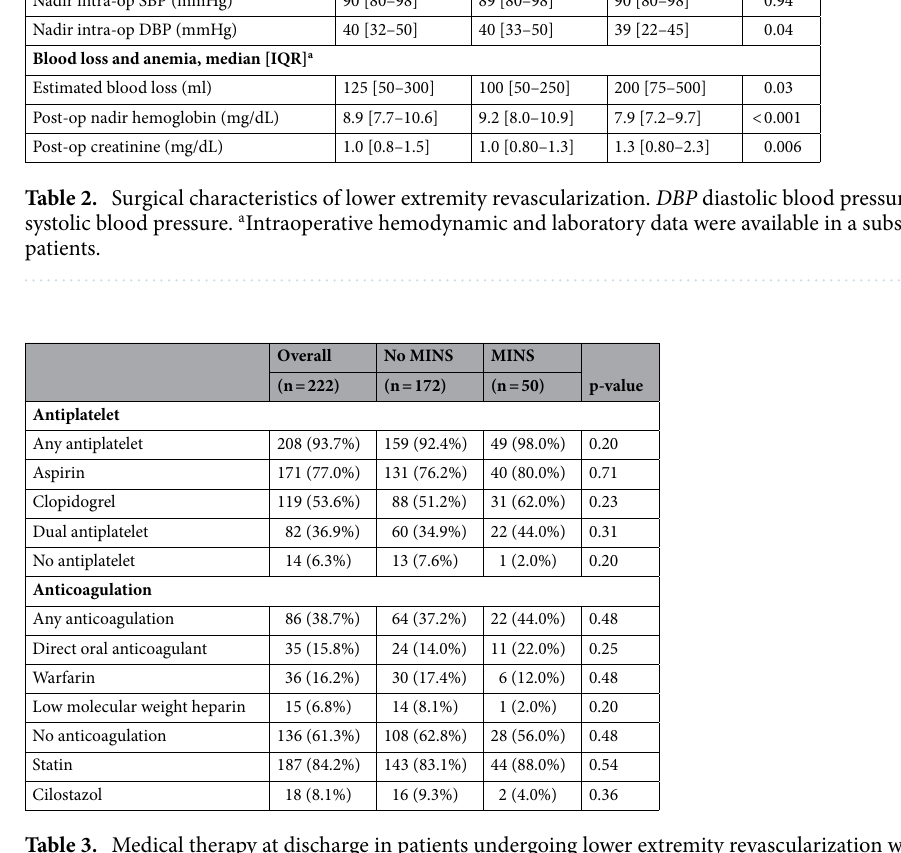
Table 3. Medical therapy at discharge in patients undergoing lower extremity revascularization with and without MINS. Excludes patients who died or were discharged to